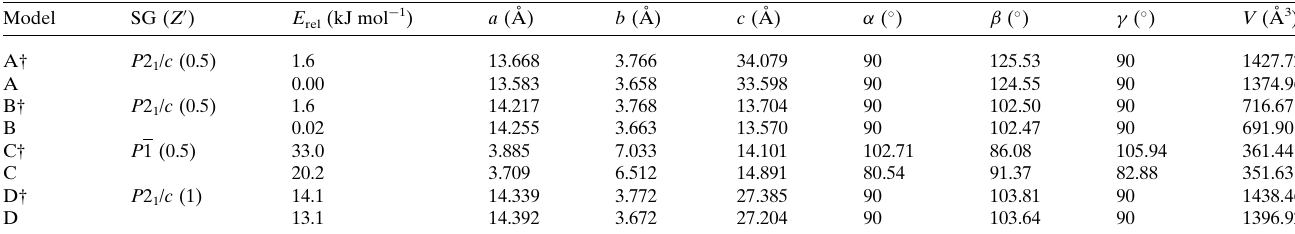
Table 9 Structural parameters of models A–D optimized by Quantum Espresso ; energies are relative to model A (relaxed cell). Model